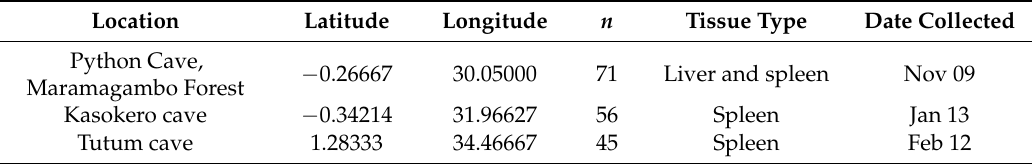
Table 1. Sampling locations and dates for Egyptian fruit bats ( R. aegyptiacus leachii ) screened for BUKV RNA [2]. Location Latitude Longitude n Tissue Type Date Collected Python Cave, − 0.26667 30.05000 71 Liver and spleen Nov 09 Maramagambo Forest Kasokero cave − 0.34214 31.96627 56 Spleen Jan 13 Tutum cave 1.28333 34.46667 45 Spleen Feb